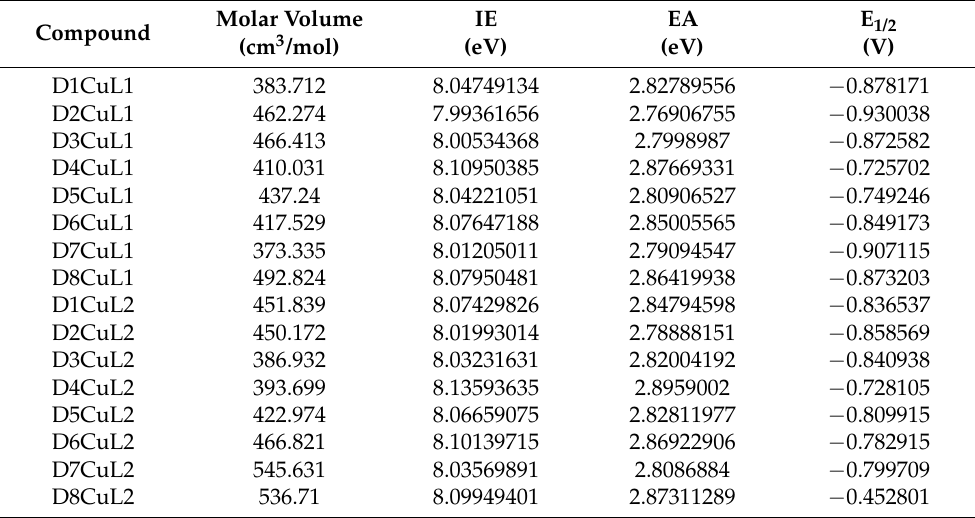
Figure 11. Born-Haber cycle used for the calculation of standard Gibbs free-energy change ( Δ G° O|R ) of mixed chelate copper(II) complexes. Table 6. Molar volume (cm 3 /mol), ionization energy (IE), electron affinities (EA) and theoretical re- dox potential (E 1/2 ) for complexes under study.